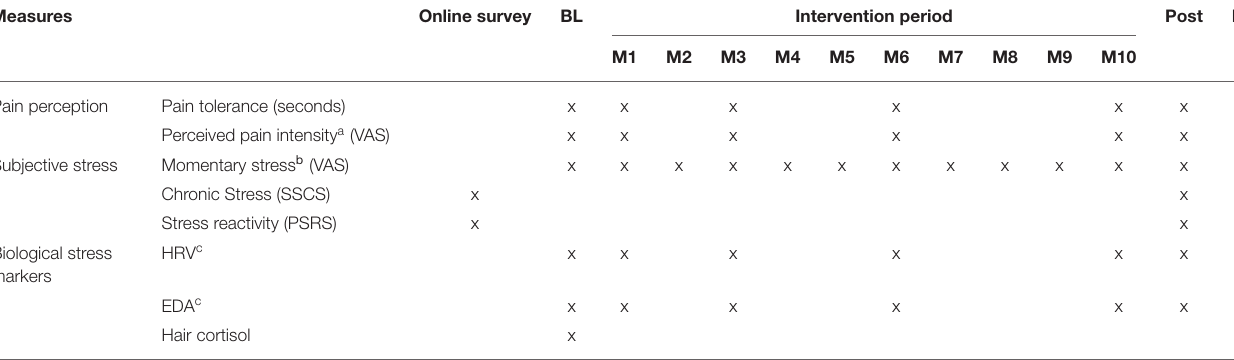
TABLE 1 | Assessment schedule for measures of pain perception and markers of stress.